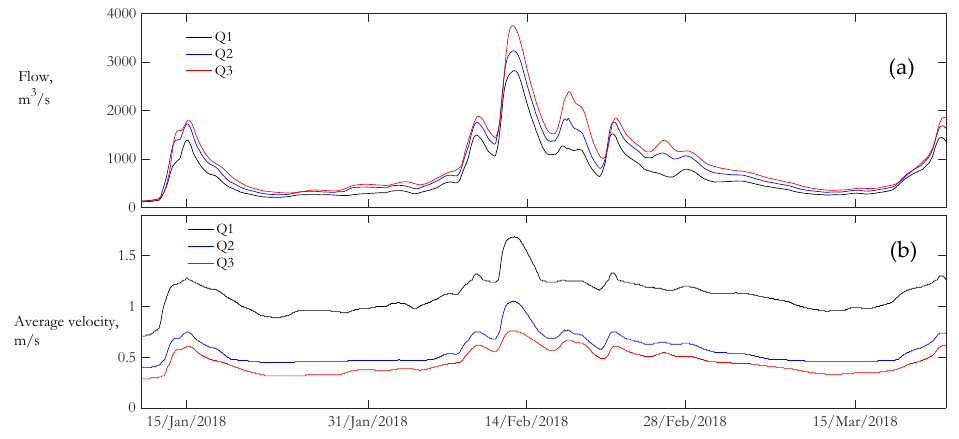
Figure 6. HSPF model predictions about ( a ) flow and ( b ) average water velocity at the locations Q1, Q2 and Q3 along the Kanawha River.